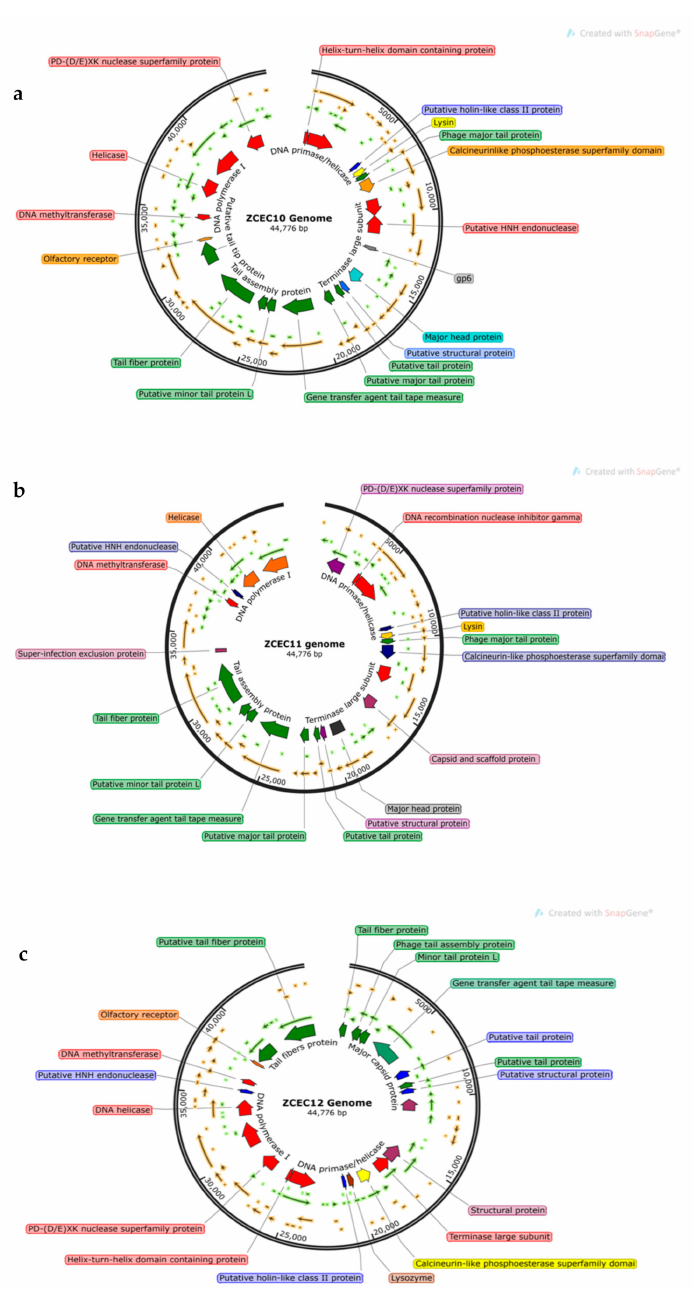
Figure 4. ( a – c ) Genetic maps of the three phages. Only functional genes are highlighted.